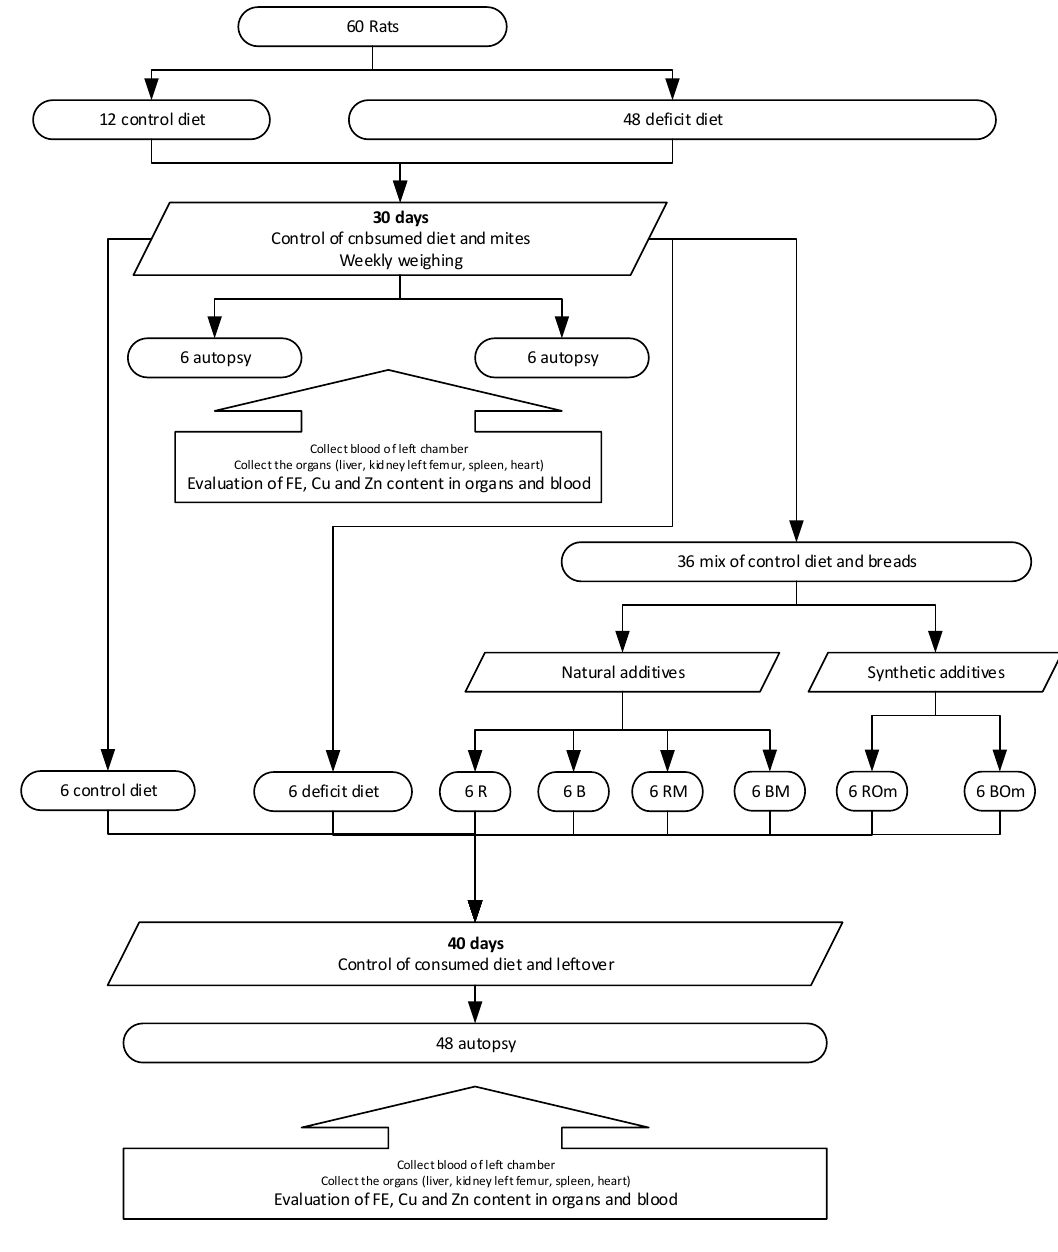
Figure 2. The in vivo experimental model.